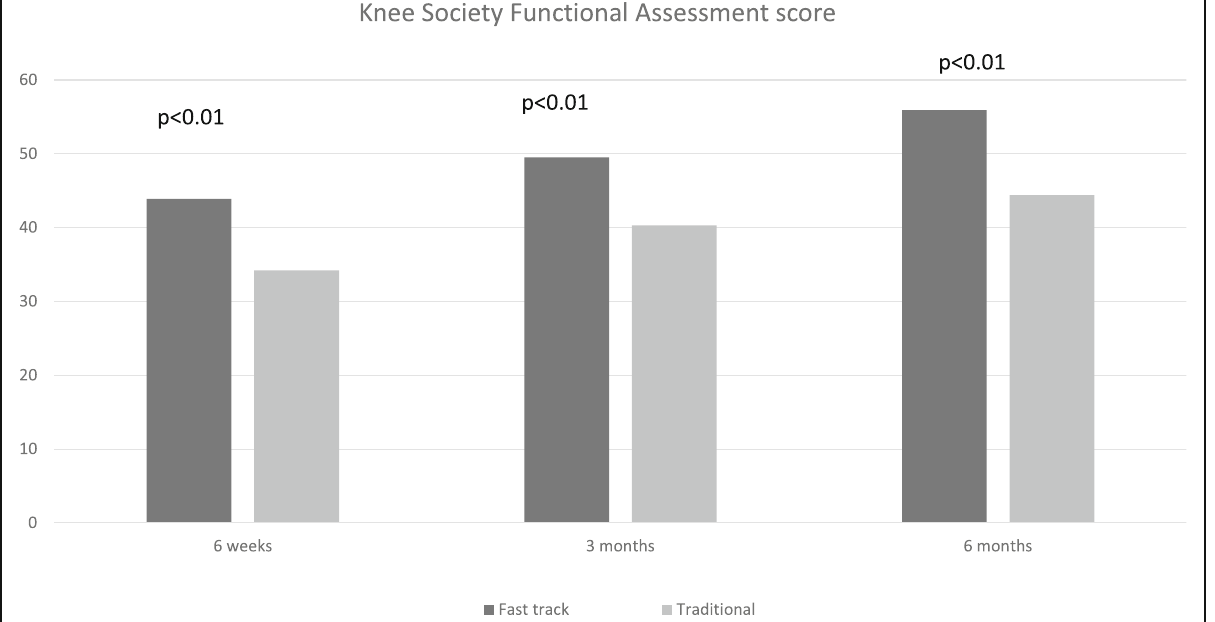
Fig. 4 KSFA scores of the fast track group compared to traditional rehabilitation group at various time